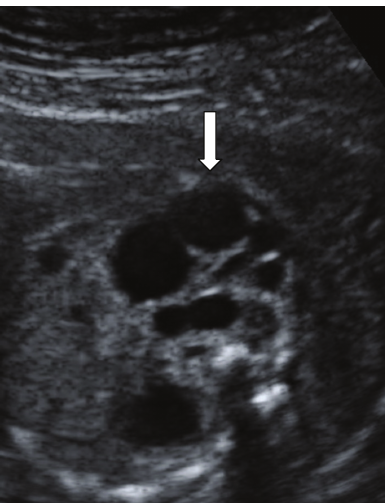
Figure 1: Color Doppler ultrasound showing the “Y sign”. Blood flow passes from the right and left ventricles, through the VSD (arrow), into an overriding enlarged aorta. Turbulent flow is shown as reddish areas around the aortic valve.